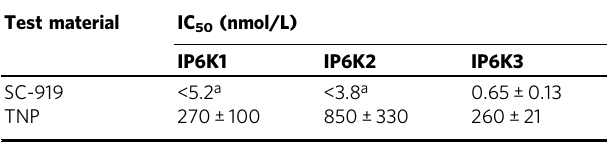
Table 1 Inhibitory activity of SC-919 on human IP6K1, human IP6K2, and human IP6K3 kinase activity.